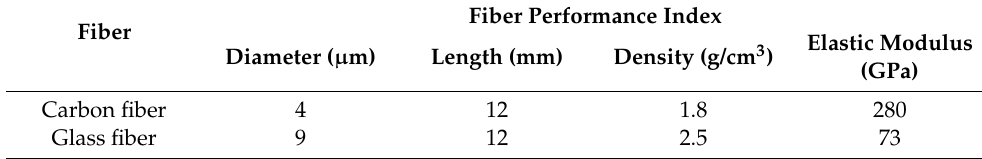
Figure 1. Test fibers: ( a ) carbon fiber, ( b ) glass fiber. Table 2. Fiber material properties.